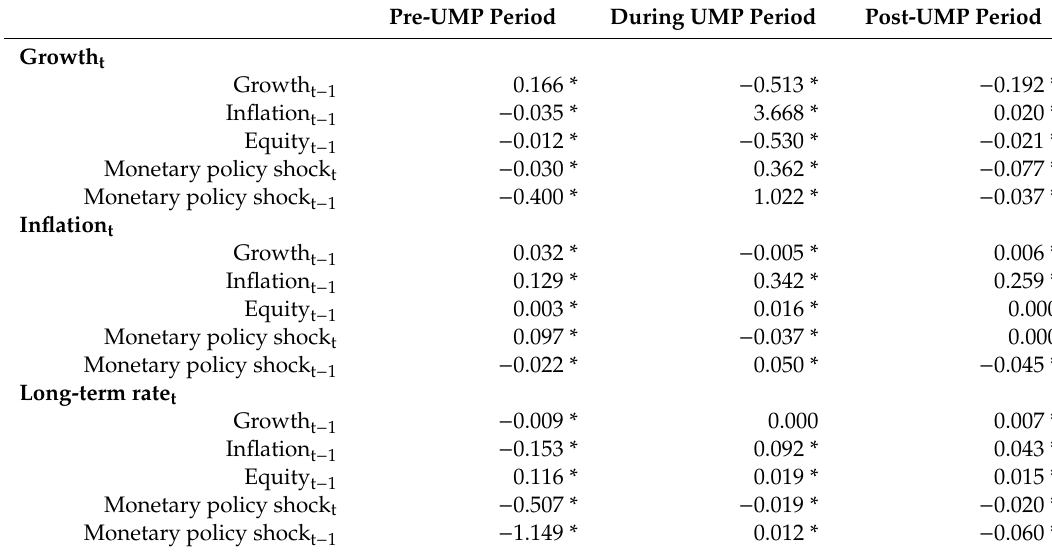
Table 4. Panel VARX estimations for long-term interest rates.